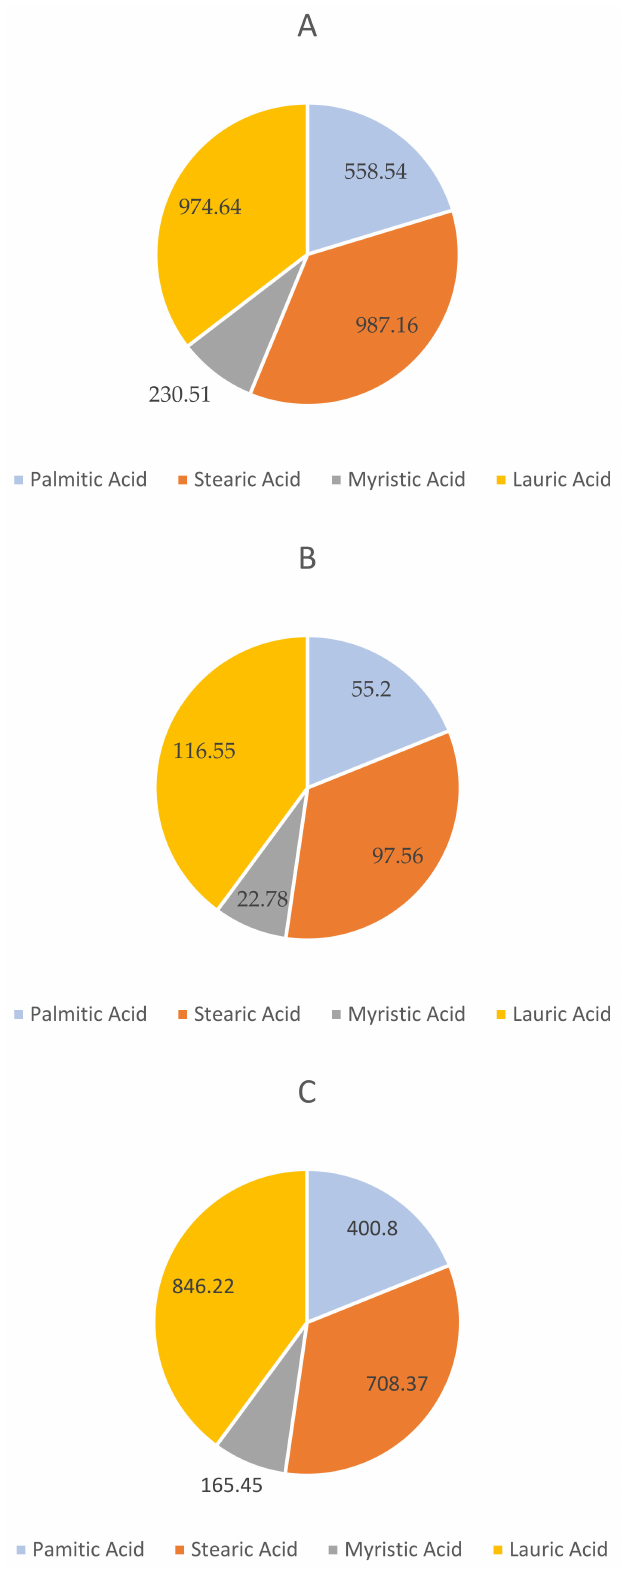
Figure 3. The revenue material flow (in kg) for ( A ) kitchen waste; ( B ) control; and ( C ) spent grain factory